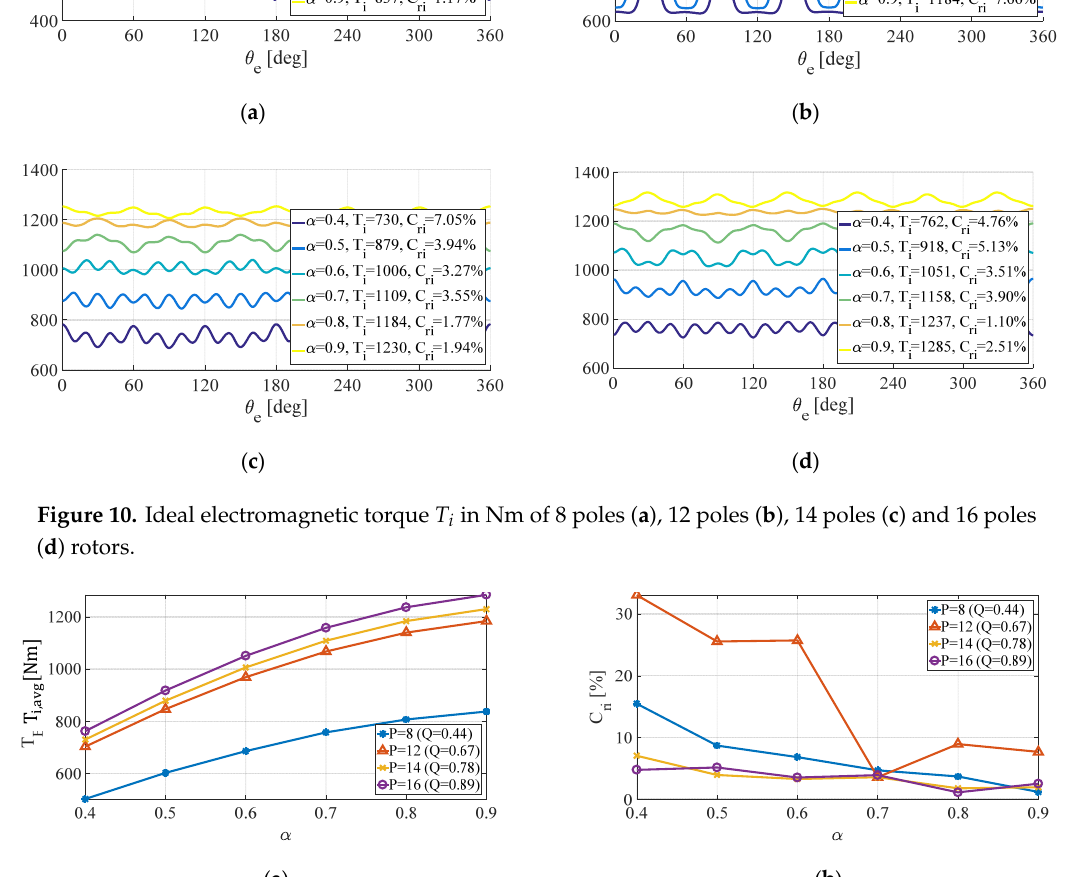
Figure 12. Cogging torque maximum (over rotor position) for different pole spans (cid:2009) . The cogging torque is caused by magnets and teeth of the machine trying to align at the points of smallest total reluctance from magnet flux point of view. Therefore, the simplest way to minimize cogging torque is to minimize the number of points (positions of rotor) at which this happens. This relation also has influence on back-emf. To achieve that, the fractional pole pitch is chosen with the lowest GCD of number of slots and number of poles. Moreover, skewing of either stator or rotor can be employed to minimize this torque. However, this relationship is in practice not that simple, especially with three dimensional flux path, so the model was used to investigate it. On the plot with the results, it can be seen that the cogging torque is rather low when compared to the ideal torque of each model. The machine with the highest count of alignment points ( (cid:1842) = 12 ) seems to exhibit the highest cogging torque, however it can be eliminated at pole span of ( ≈ 0.7 ). Other machine configuration cogging torques tend to decrease with increasing pole span coefficient. It is important to remind that these AF machines have non-radial stator cores, which do not align with rotor magnets, which significantly decreases cogging torque.